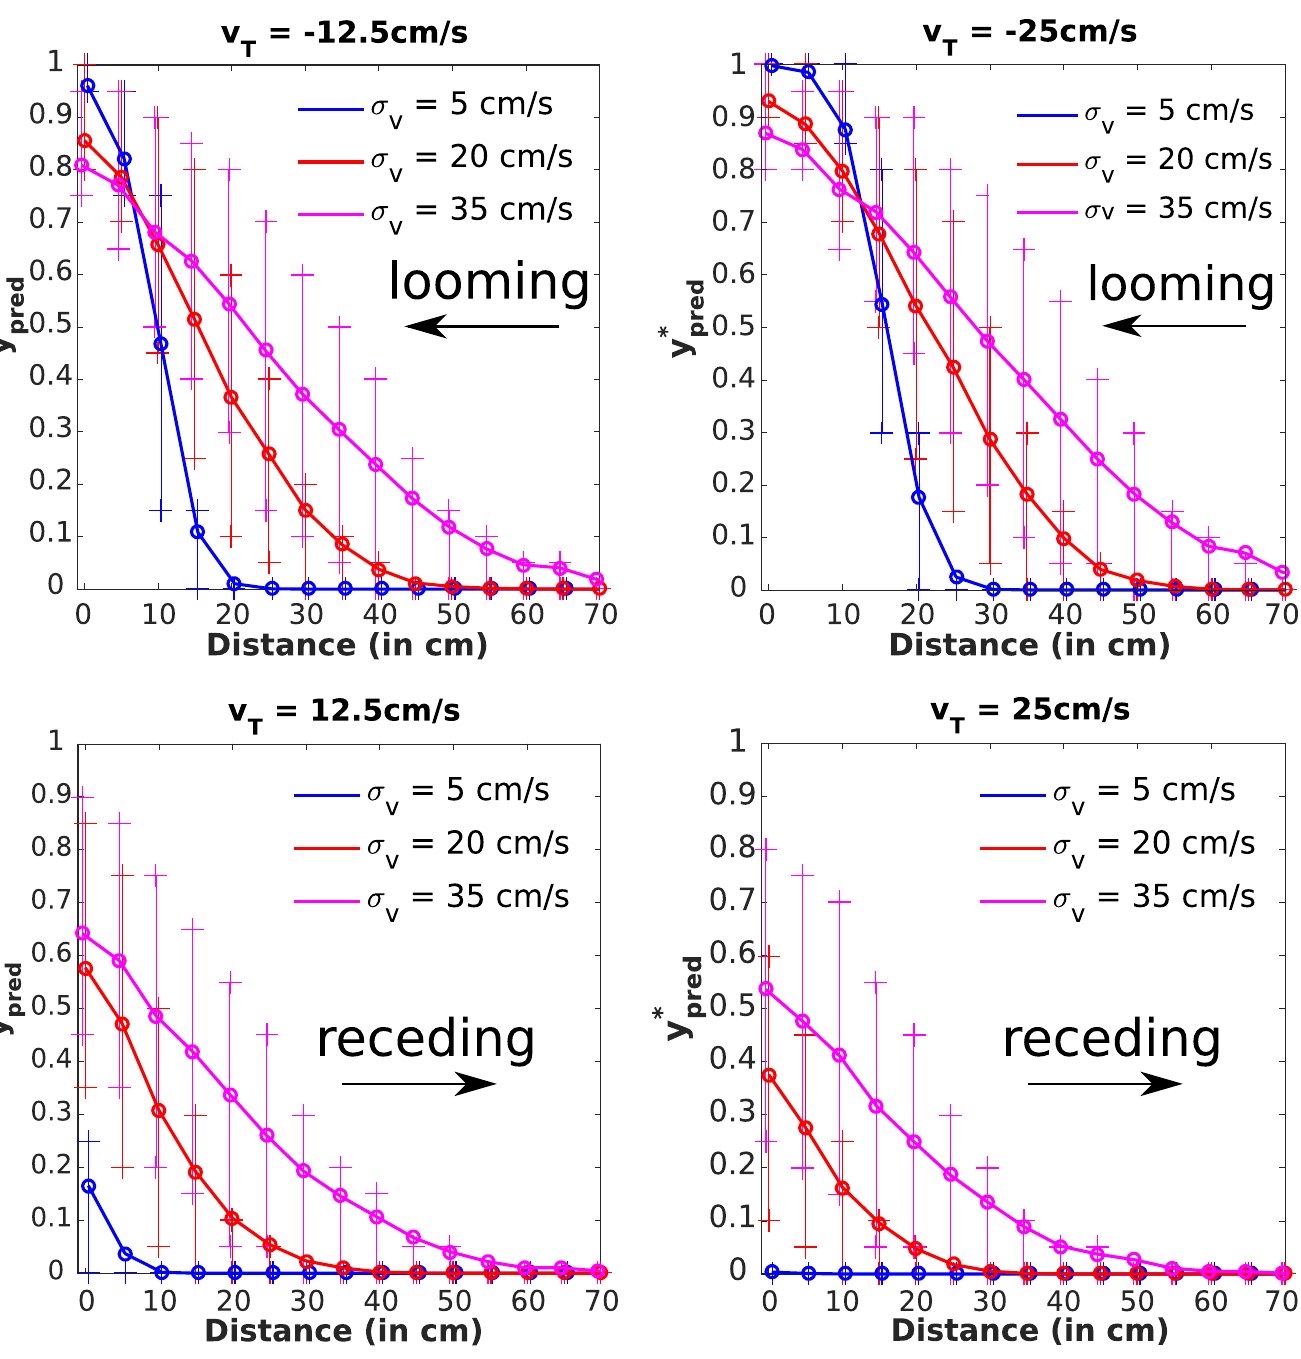
Fig 6. A looming stimulus leads to a higher response than a receding one. The stimulus is looming (receding) to (from) the body with velocity v s. The horizontal axis is the distance x T of the stimulus from the body. The vertical axis corresponds to the impact prediction y � percentiles of 1000 predictions for each distance. ( Left column ) The speed of the stimulus was v T = ± 12.5 cm / s .Although the prediction values were significantly smaller for the receding movement, it was still slow enough to get significant impact prediction values even for the receding movement. With increasing velocity uncertainty σ v of the stimulus, the prediction values increased. ( Right column ) Speed was increased to v T = ± 25 cm / s .This led to reduction of impact prediction values for the receding movement compared with the smaller speed case. The parameters not listed here take values from Table 1. See S2 Fig for a version with FN = y � pred FP =